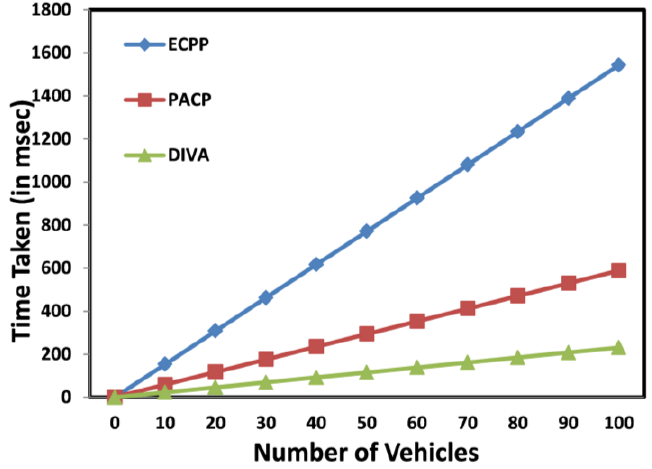
Figure 6. Comparison of protocol latency at RSU